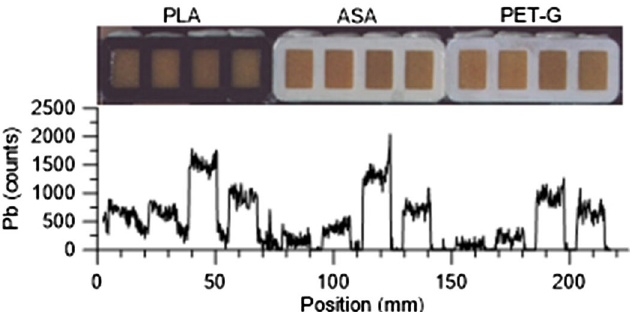
Figure 7. Comparison of the Pb signal between the three prototypes tested (Black = PLA, middle white = ASA, right white = PET-G). Note the considerably higher levels measured over the compartment walls for the PLA carrier compared to the levels in the ASA and the PET-G carriers. All carriers loaded with (left to right) untreated resin, resin exposed to deionized water, resin exposed to 10 ppm solution, resin exposed to < 10 ppm